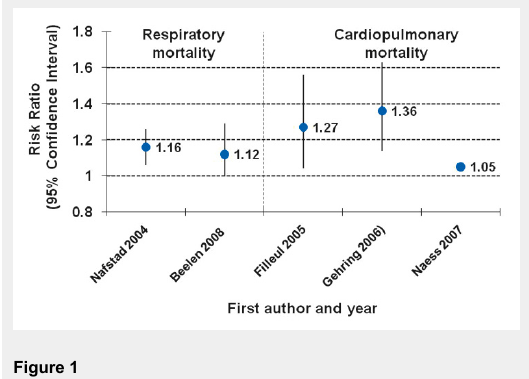
Relative risks (RR) for respiratory [44, 45] or cardiopulmonary mortality [46–48] with 95% confidence intervals (CI) from European cohort studies on air pollution expressed per 10 µg × m –3 NO 2 or NO x . (No CI available for cardiopulmonary estimate in [48].)